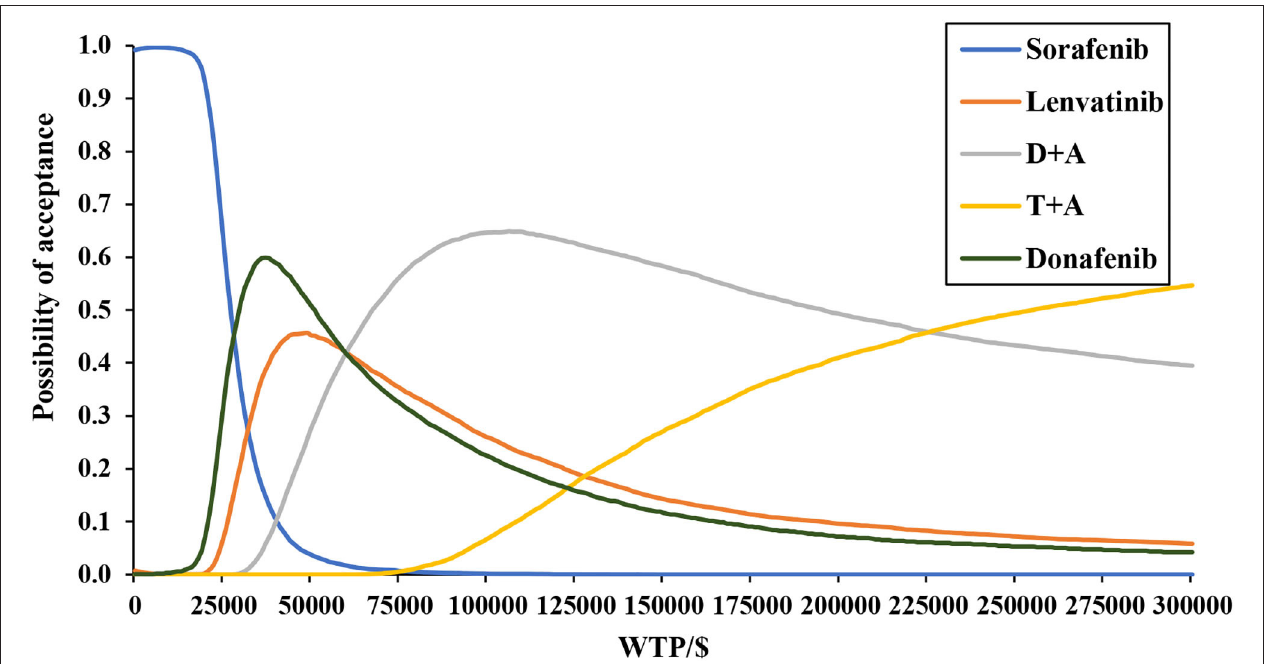
FIGURE 4 | Base-case probabilistic sensitivity analysis: cost-effectiveness acceptability curve (10,000